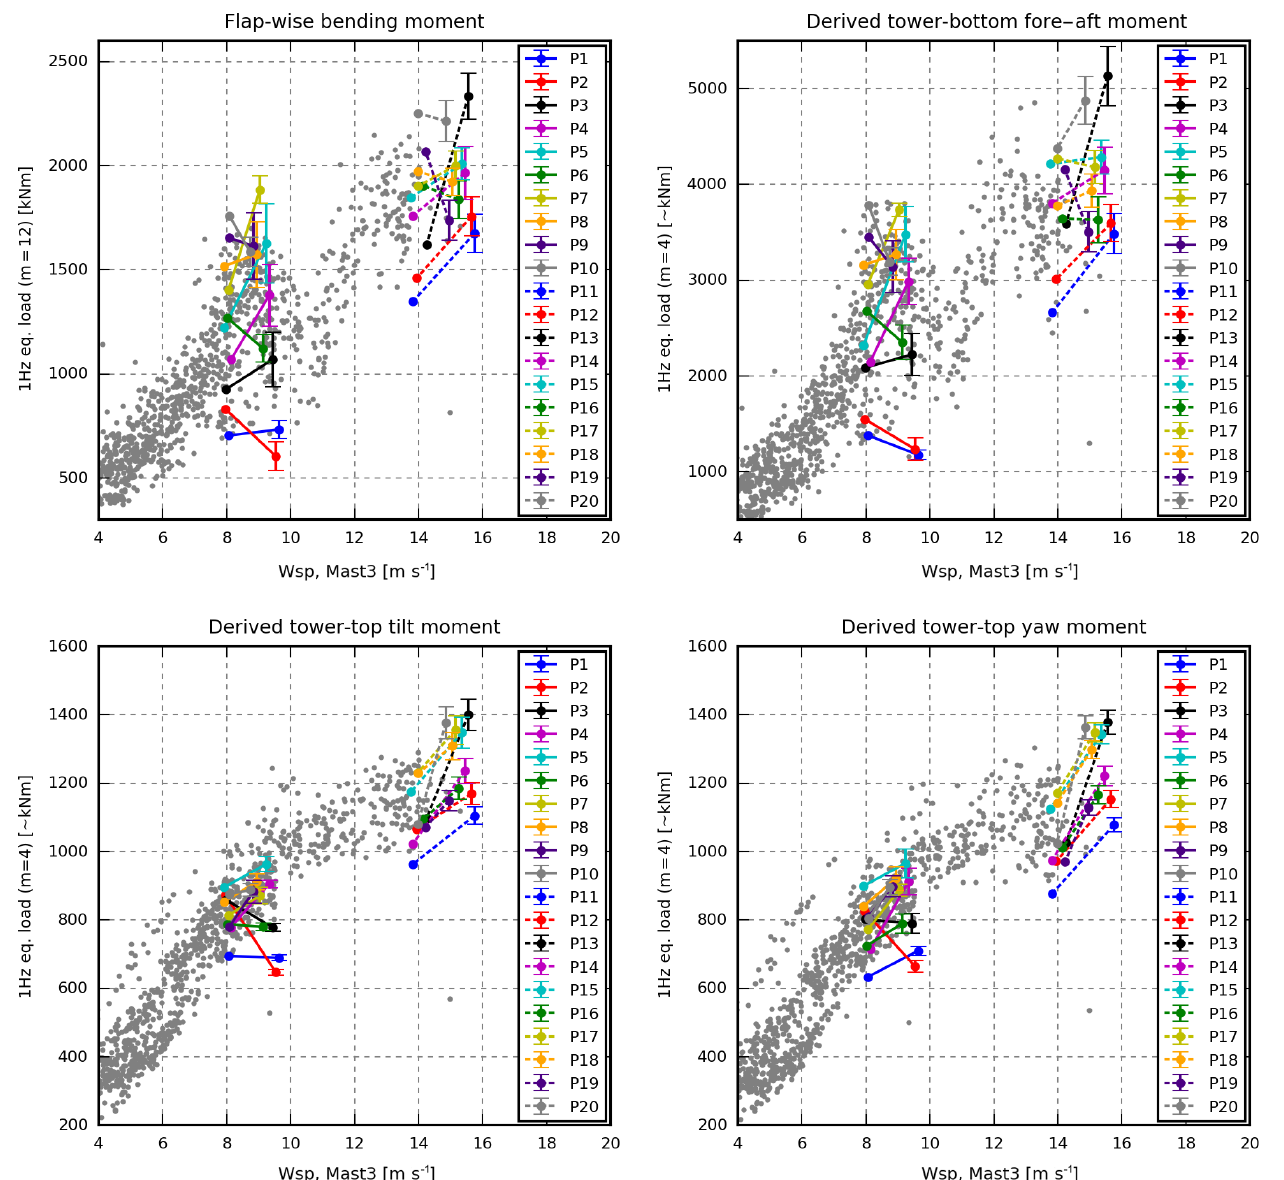
Figure 15. Case 2. Best case based on met-mast inflow information. For interpretation see Fig.